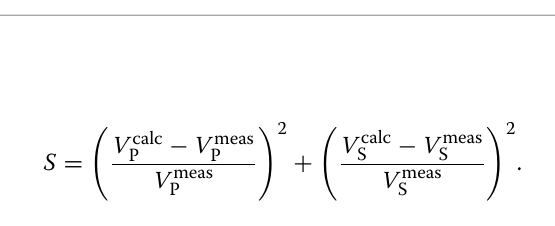
Fig. 6 SEM images of progressive slices of a crack in a dry sample AJG02. A white area in the upper part is a platinum layer for the protection from the ion beam